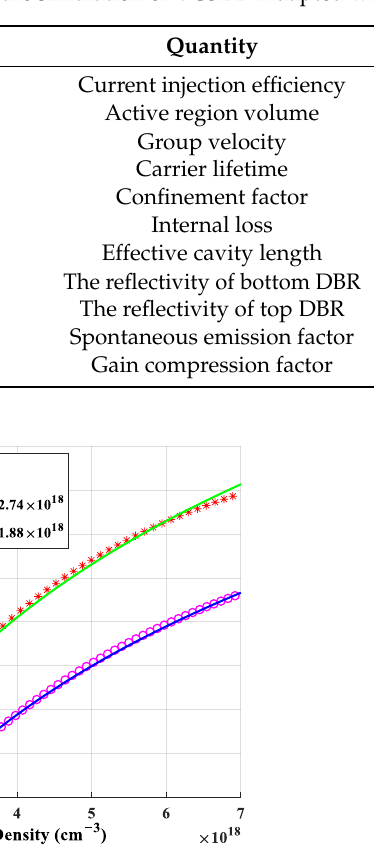
Table 2. Parameters used in the simulation of VCSEL. Adapted with permission from [5].